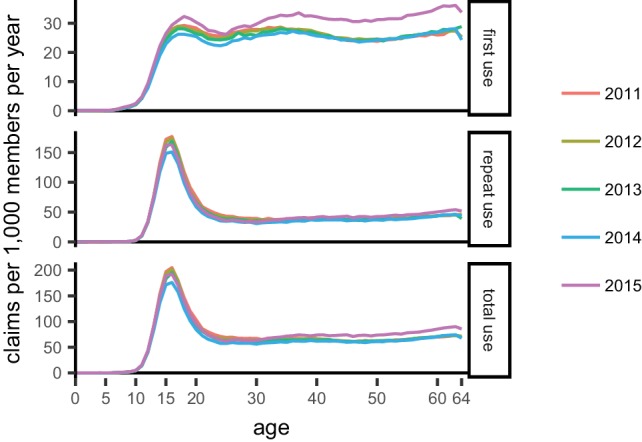
Distribution of tetracycline use by age.Colors indicate data years.